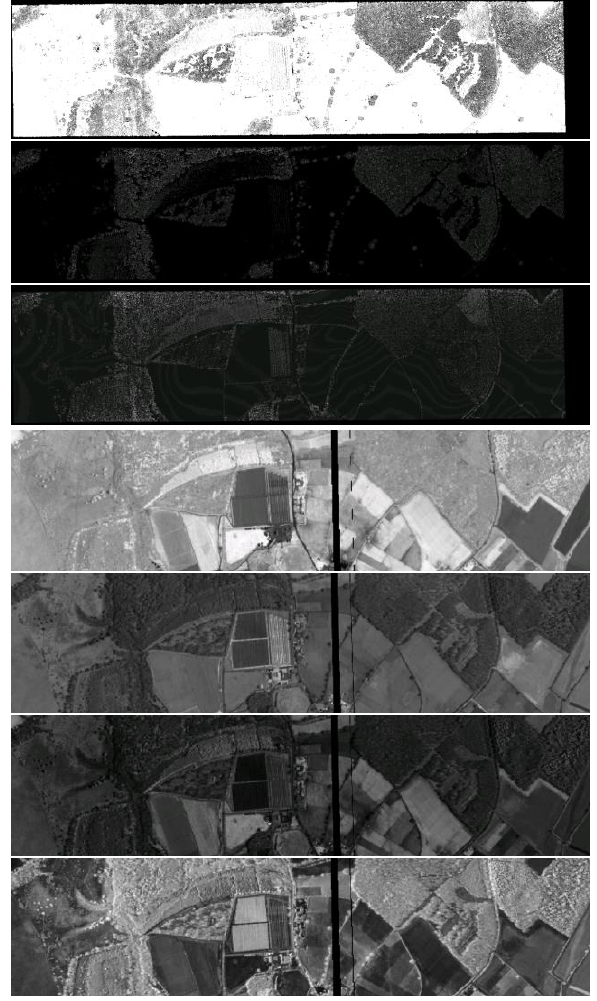
Figure 7. Metrics (Table 6) from the same flightline, with brighter intensity indicating a higher-valued metric